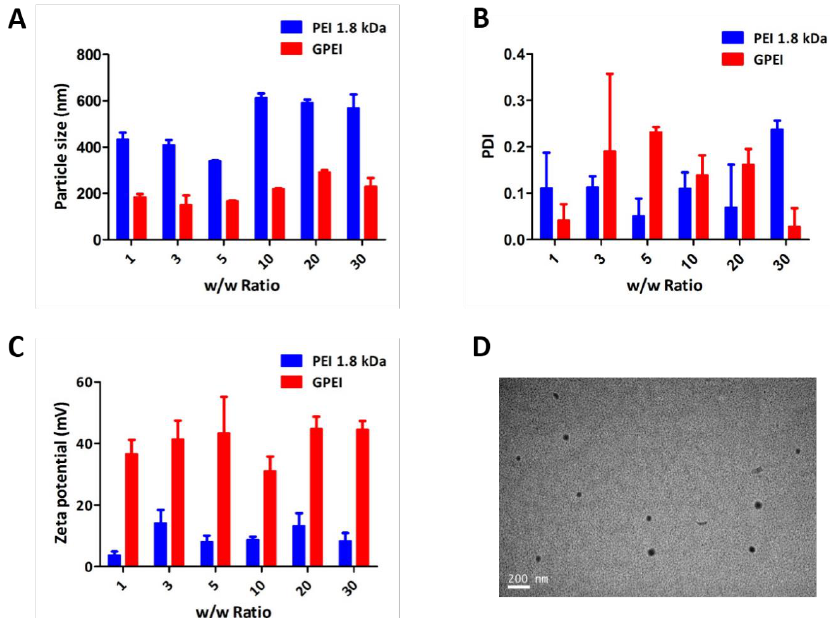
Figure 3. Physiochemical properties of the GPEI polyplexes. ( A ) Particle sizes, ( B ) polydispersity index (PDI), and ( C ) zeta potential of the GPEI and PEI 1.8 kDa polyplexes. ( D ) TEM images of the GPEI polyplexes ( w / w ratio = 5). Bars = 200 nm.